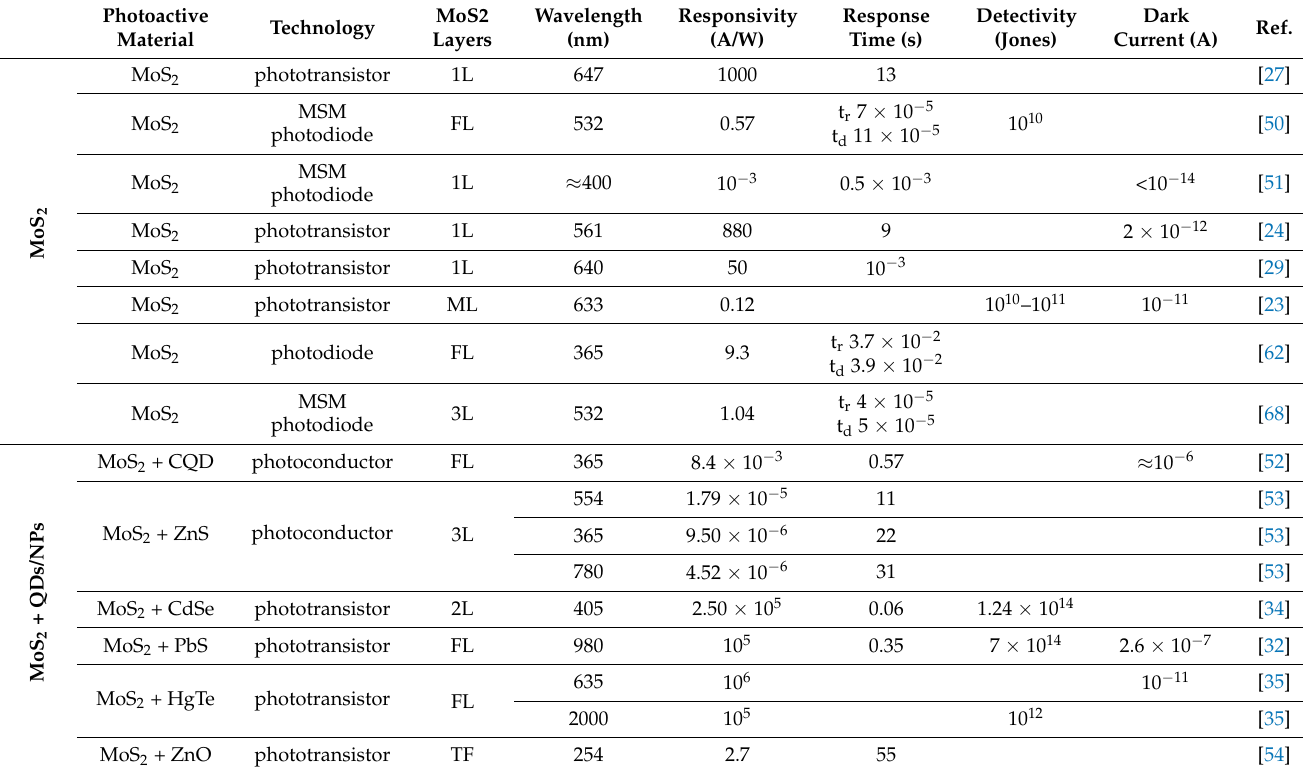
Table 1. MoS2-based photodetector performance. FL = few layers, ML = multilayer, TF = thin film, t r = rise time, t d = decay time. Photoactive